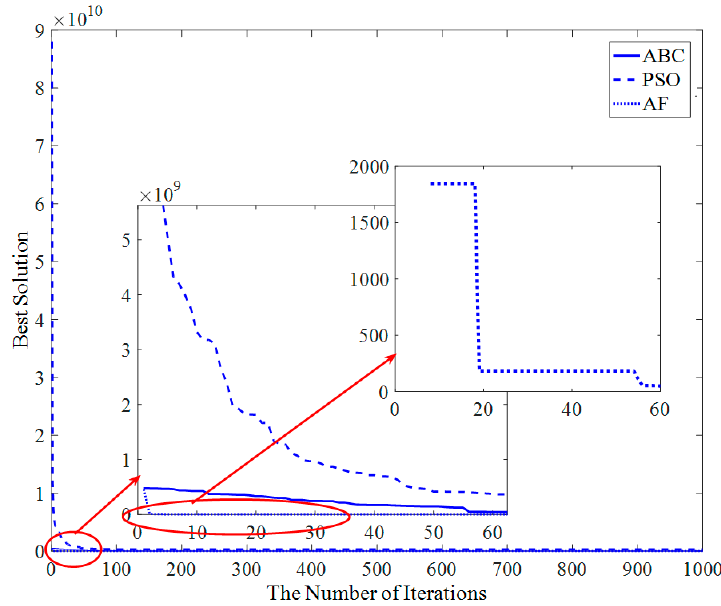
Figure 10. The convergence curve of the three algorithms for Rosenbrock function in 50-dimensional space.